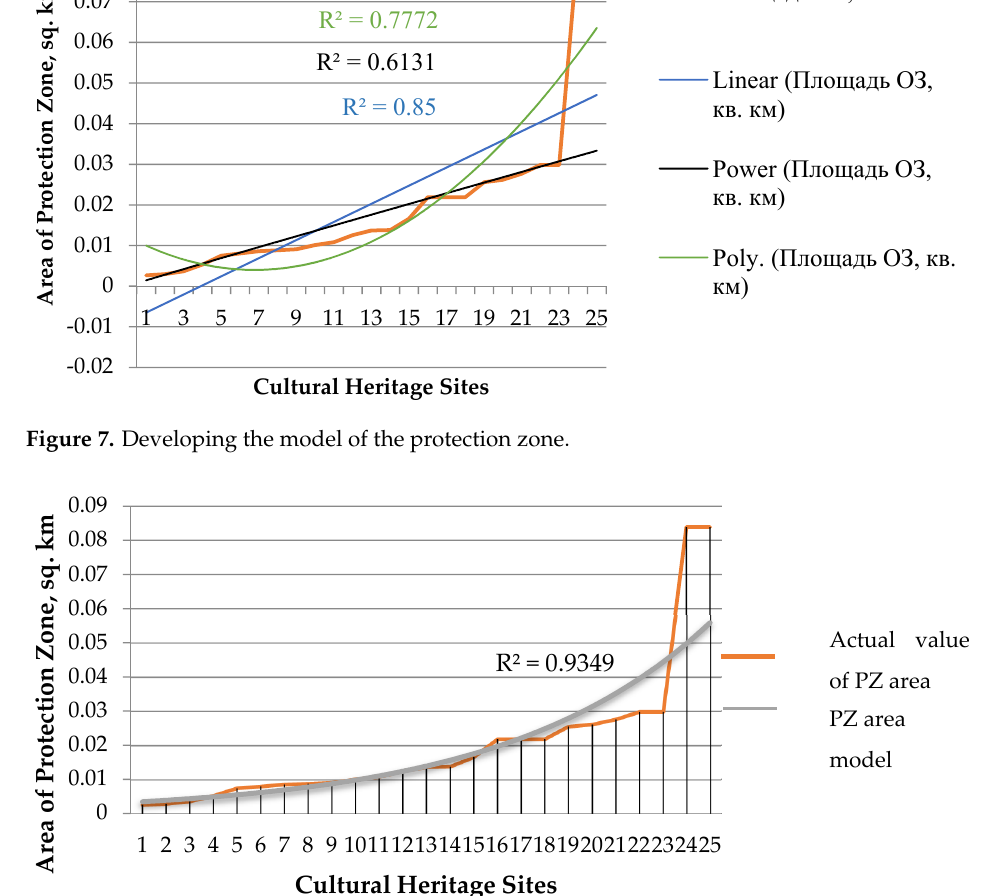
Figure 8. Model plot of the size of the protection zone of cultural heritage sites in the example of Orenburg, km 2 .